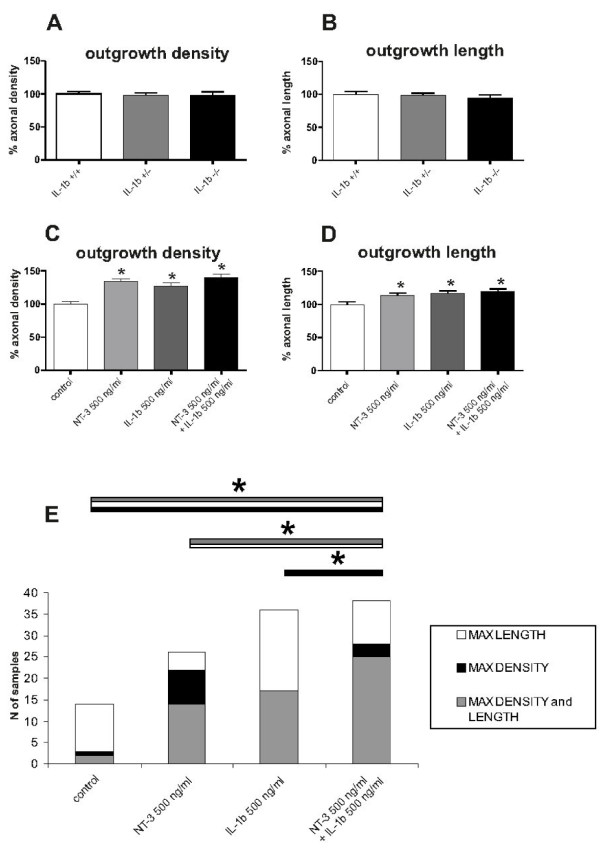
Neurite outgrowth is independent on endogenous IL-1beta and is synergistically stimulated by combined application of NT-3 and IL-1beta. A + B: Neurite outgrowth (neurite density A and neurite length B) was not influenced in the absence of endogenous IL-1β in IL-1β-deficient mice. Heterozygous IL-1β-deficient and wildtype mice served as controls. n: 50 slices. C + D: The combined administration of NT-3 and IL-1β shows only a slight increase in neurite density and length, if compared to single treatments. n = 84 slices. *: Statistically significant difference to control; p < 0.05 (Mann Whitney U test). Error bars represent SEM. E: Chi-square analysis reveals a significant difference in the frequency of brain slices with maximal outgrowth between single treatments with NT3 or IL-1β and the combined administration of both factors. Particularly double treatment presents a significant increase in the number of slices reaching maximum density if compared to control and single treatment with IL-1β, and in length if compared to single treatment with NT3. Additionally, combination of the two factors is also characterized by a significantly higher number of slices which hit the maximum in both parameters, if compared to control condition or single treatment with NT3 (to increase the readability of the graph only the significances relative to the double treatment have been included). *: Statistically significant difference; p < 0.05 (Chi-square).